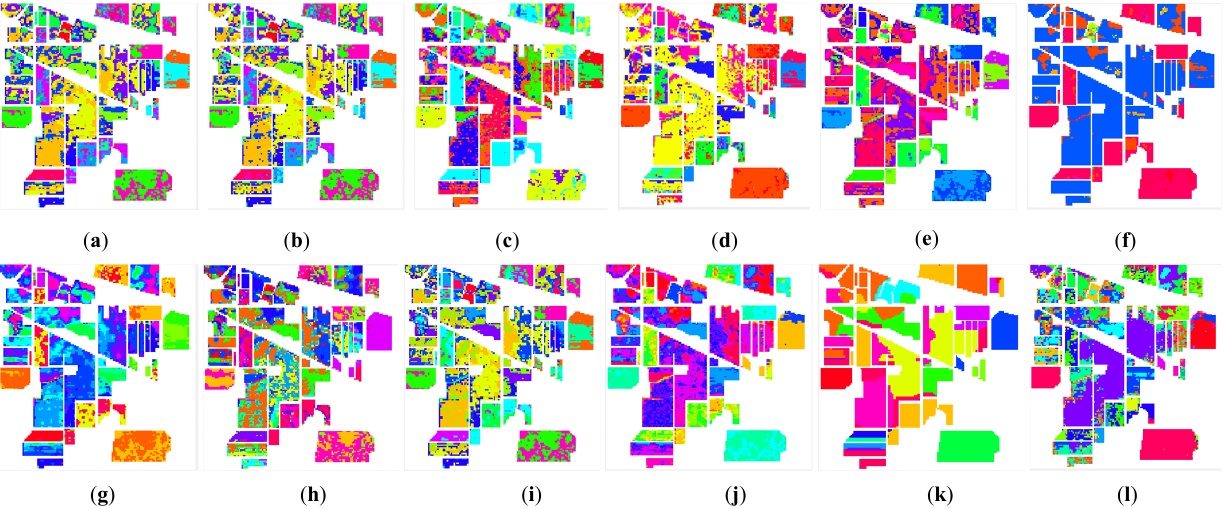
Figure 5. The clustering maps of the Indian Pines dataset. ( a ) K-means. ( b ) K-methods. ( c ) GMM.